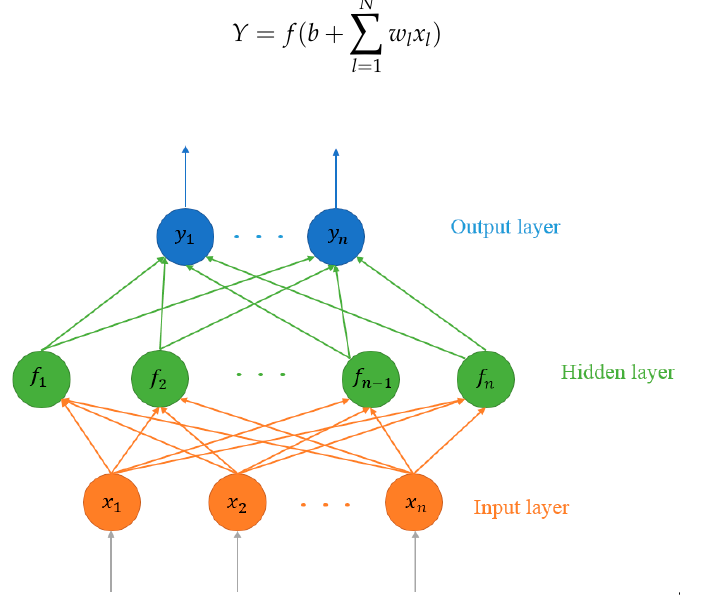
Figure 1. Basic structure of multilayer perceptron (MLP).